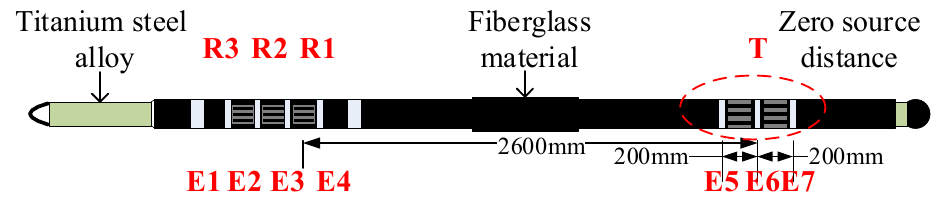
Figure 1. AELT Figure 1. AELT 2.0.